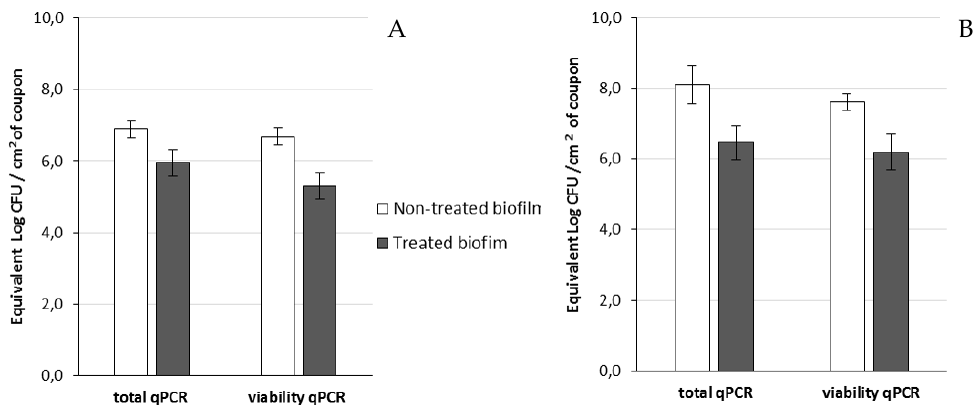
Figure 7. Effect of the bacteriophage 14.1 on 24 h old biofilms of P. aeruginosa ( A ) on the PAO1 reference strain and ( B ) on D1 isolates from the thermal environment. The data represent the average of three biological replicates and the standard deviations are indicated by vertical bars.